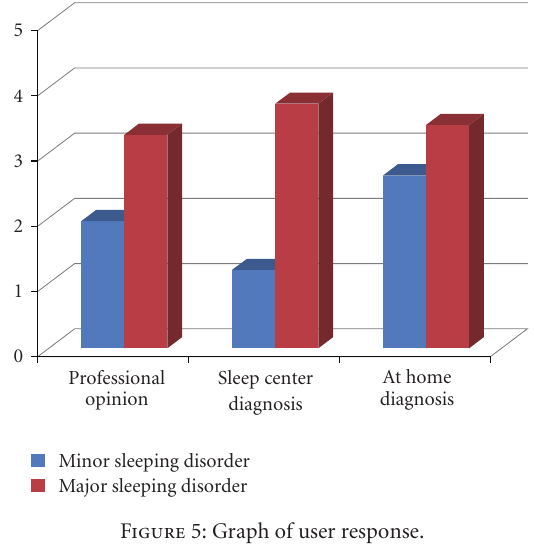
Figure 5: Graph of user response.